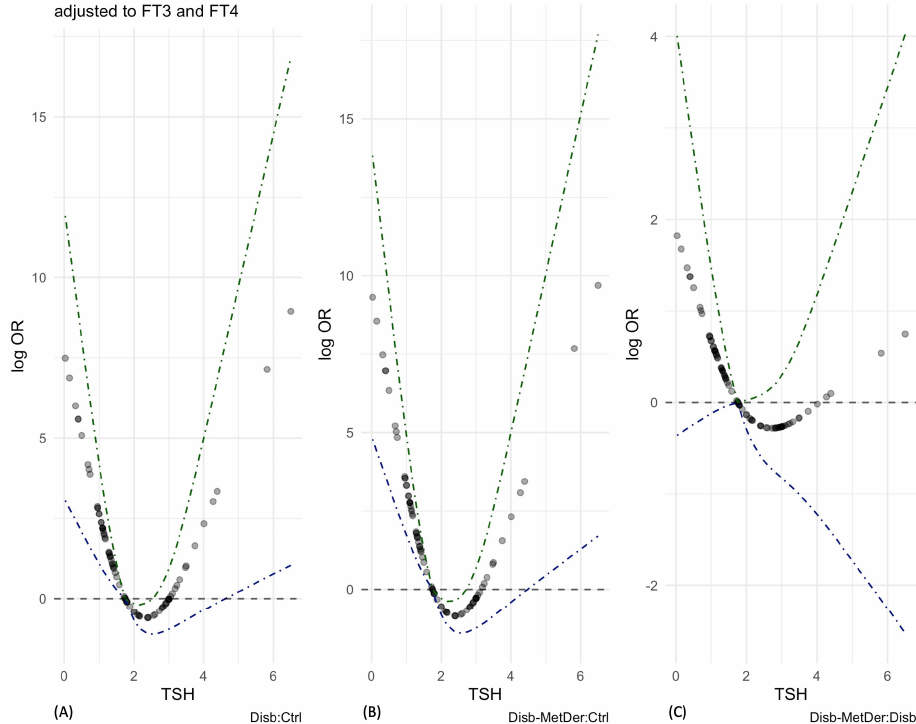
Figure 3. In this panel, the three subfigures represent the non-linear effect of TSH as it is related to the three classes of the groups studied. In all three comparisons (i.e., children with neuromotor impairment versus control children; children with neuromotor impairment and metabolic syndrome versus control children; children with neuromotor impairment and metabolic syndrome versus children with neuromotor impairment only), the probability of being a child with neuromotor impairment with or without MS decreases with increasing TSH levels up to 2.5 mLU/L, then the probability increases with increasing TSH levels above 2.5 mLU/L. Considering the median TSH value (1.75 mLU/L), the confidence intervals of the logarithm of the odds ratios are above the horizontal line set at 0 between the minimum and median TSH value and below between the median value and a TSH value of 2.5 mLU/L. As a function of TSH values above 4.5 mIU/L, they narrow and do not include the horizontal line set at 0 for either of the first two comparisons ( A , B ). However, when considering the log odds ratios between children with disabilities and MS and children with disabilities only, although a similar pattern is observed, the confidence intervals are very wide and the horizontal reference line of 0 is always included, with no evidence of association ( C ). Disab = disability; Ctrl = controls; MetDer = metabolic derangement.